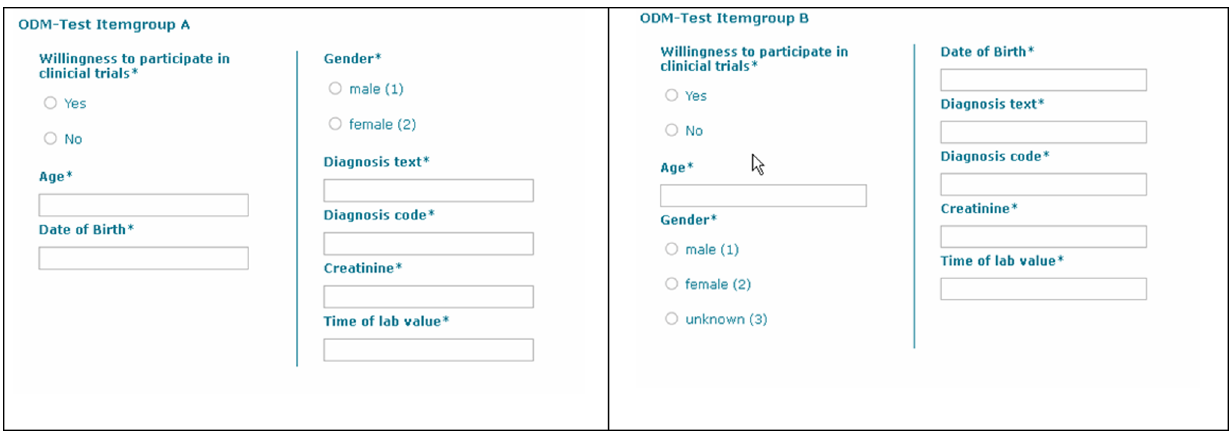
Figure 1. Overview of two simple forms with 8 items each. Different data types are available, for example categorical (‘‘Willingness to participate in clinical trials’’), integer (‘‘Age’’) and date (‘‘Date of Birth’’).